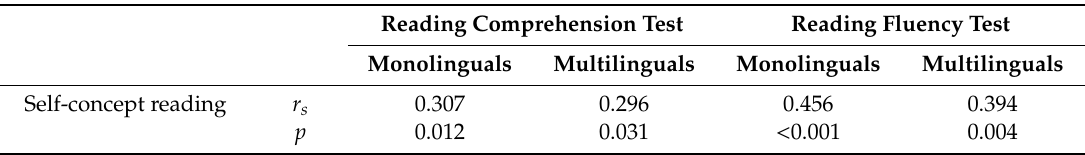
Table 4. Correlations between self-concept for reading and standardized reading tests for monolinguals and multilinguals. Bivariate correlations between variables utilized Spearman’s rho.